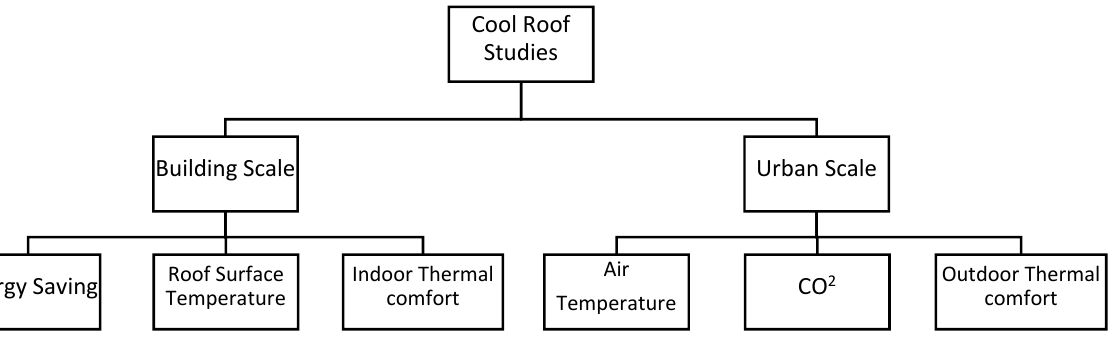
Figure 2. Overview of the level of investigation of selected cool roof studies, with their objectives and test parameters.